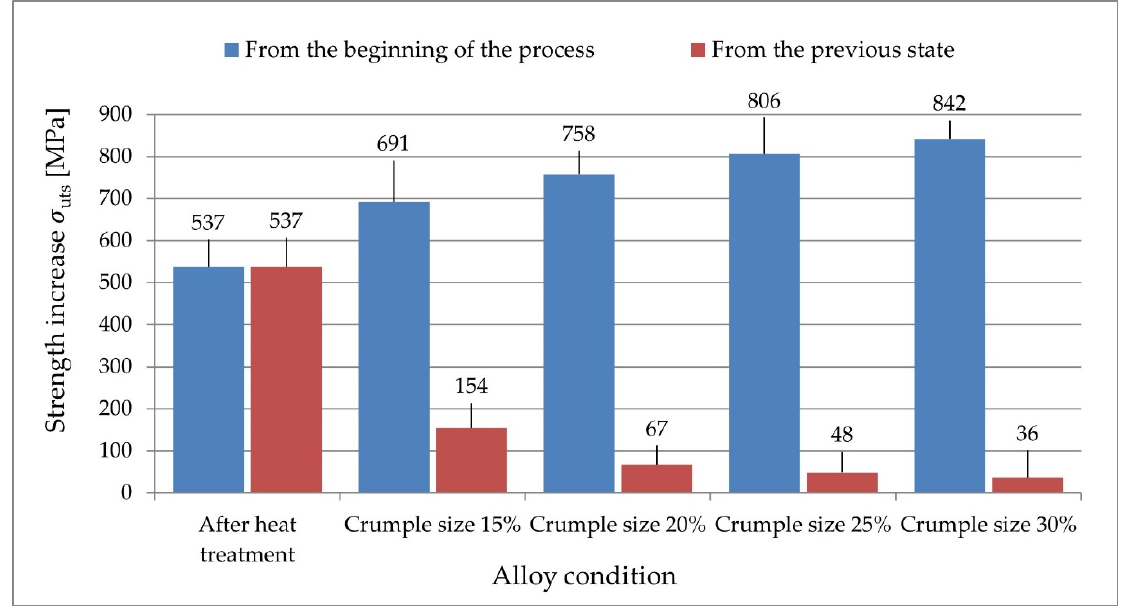
Figure 13. Increase in tensile strength for different WHA states.